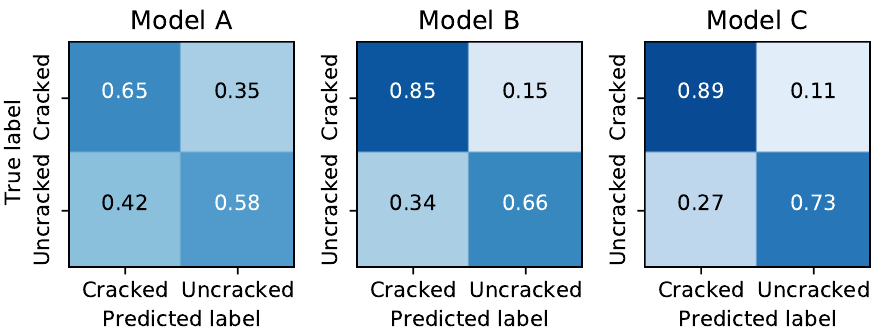
Figure 8. Confusion matrices for each architecture when tested on real-world